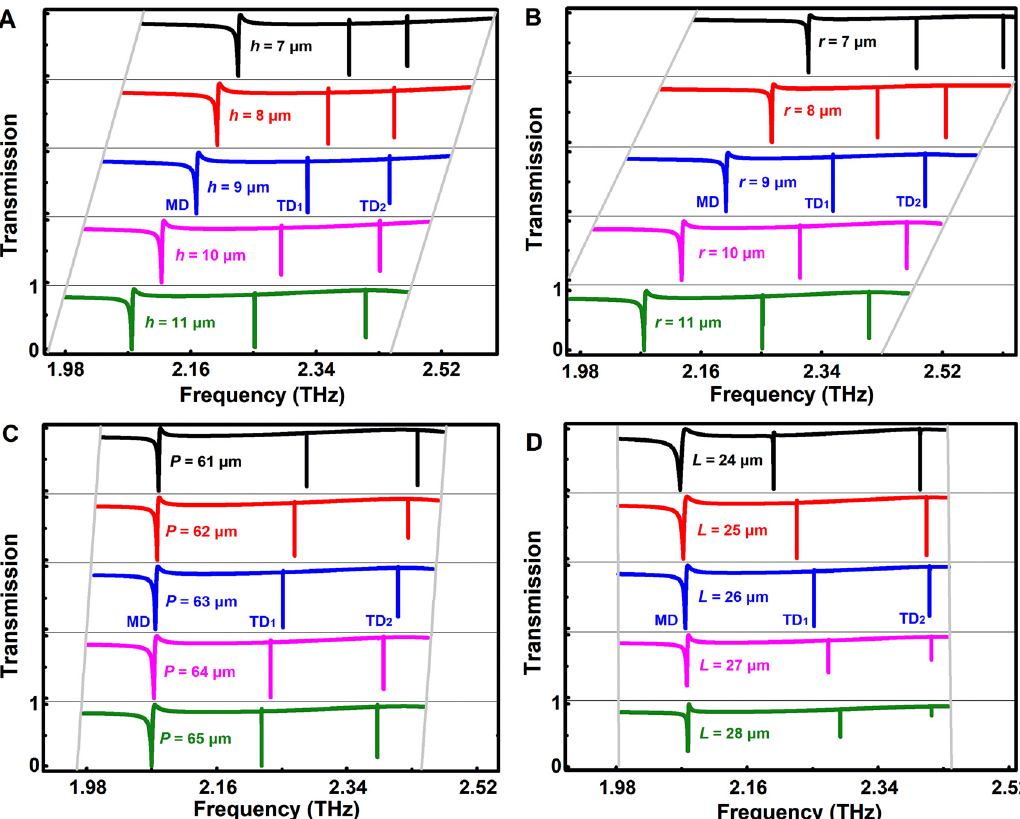
Figure 7: Transmission spectra of the asymmetric metasurface structure ( a = 0.4 μ m) with different (A) height h, (B) radius r , (C) period P , and (D) distance L